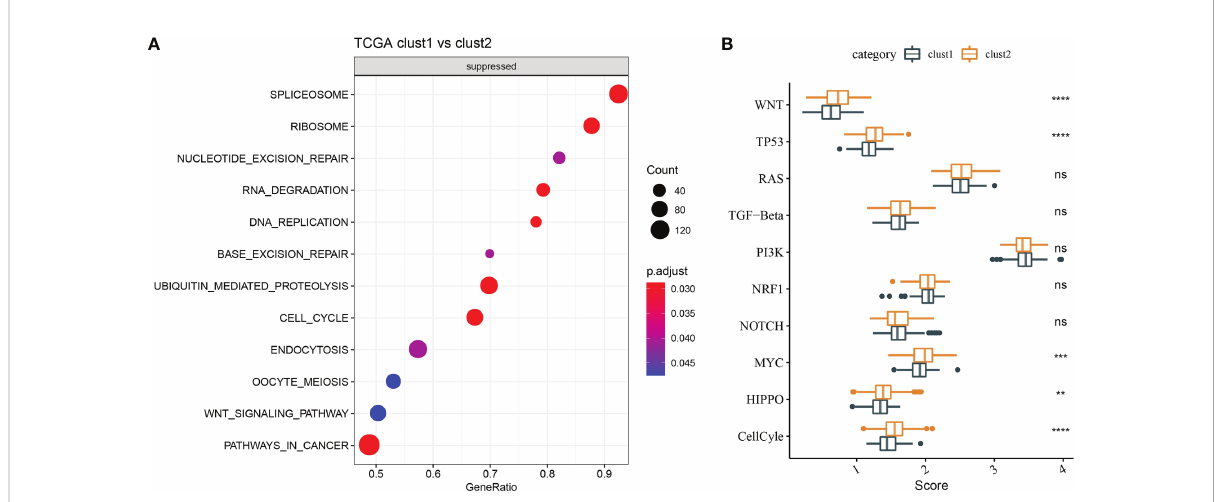
FIGURE 6 Functional enrichment analysis. (A) GSEA demonstrated that pathways, such as cell cycle, were activated in Clust1. (B) Five of 10 pathways associated with tumorigenesis had higher scores in Clust2. **p<0.01, ***p<0.001, ****p<0.0001, ns, no signi fi cance.